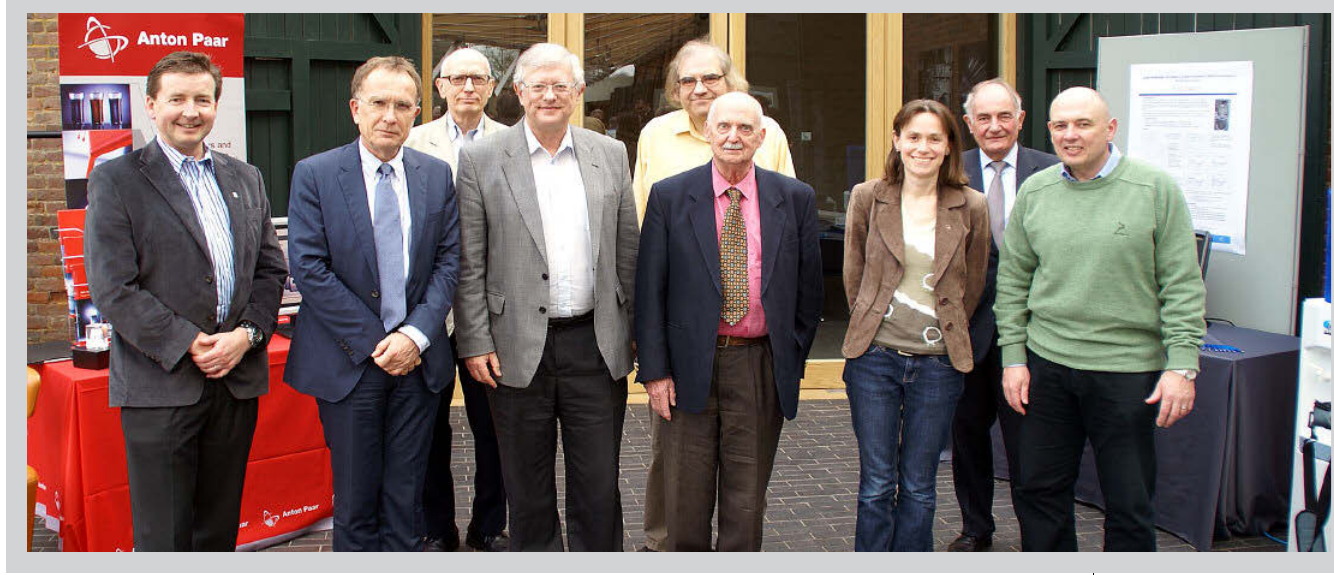
Figure 1: Russel Davies with the